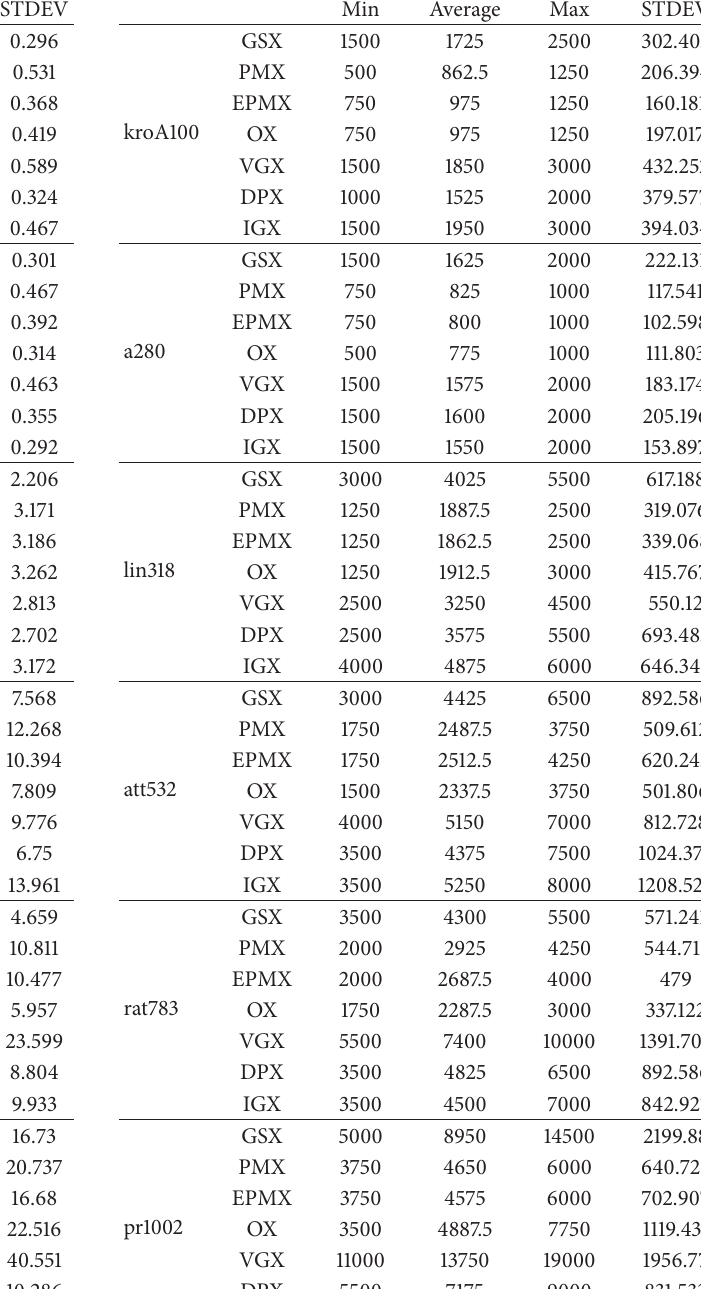
Table 5: Required runtime for generational GA with each crossover. Table 6: Total generations